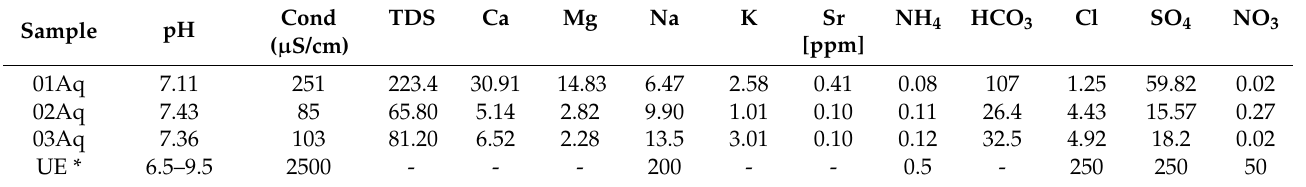
Table 3. Chemical composition of the water samples from